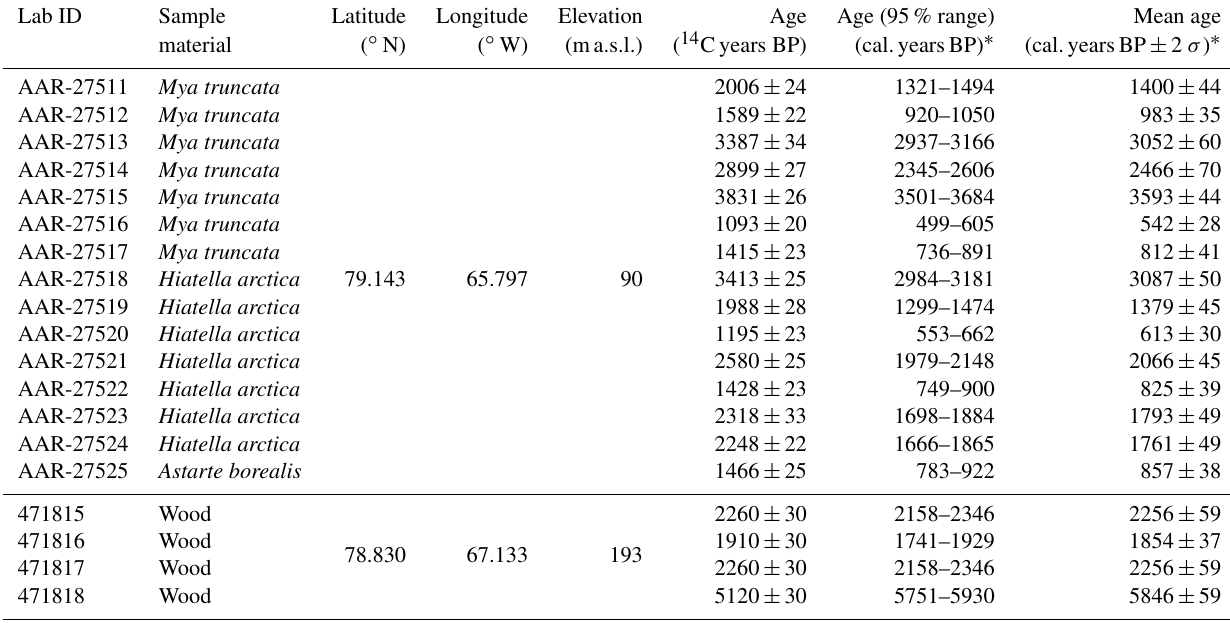
Table 3. Sample collection information, radiocarbon ages and calibrated ages for marine molluscs collected at the margin of the Humboldt Glacier and wood fragments collected in front of the Hiawatha Glacier, north